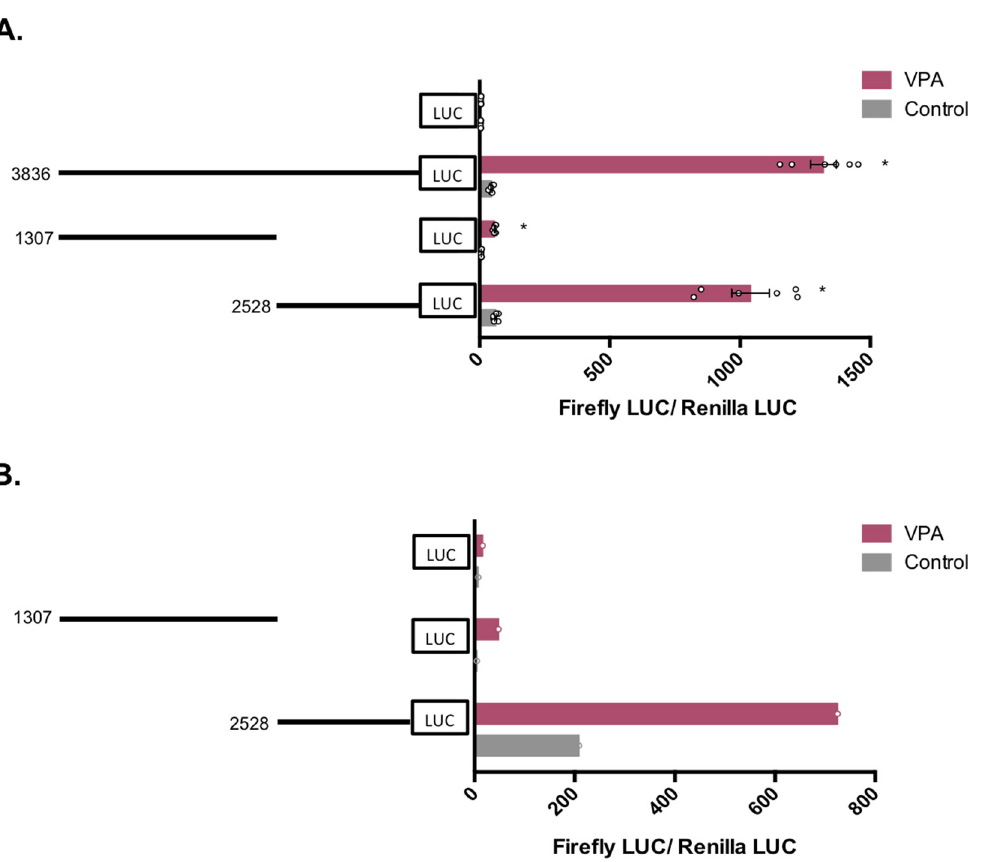
Figure 4. Response of three hVDR (human Vitamin D Receptor) gene promoter regions of 3836 bp, 1307 bp, and 2528 bp to VPA (valproic acid). HepG2 cells ( A ) or human hepatocytes ( B ) were transfected with the pGL4-VDR-3836 ( − 1899 to +1937), pGL4-VDR-1307 ( − 1899 to − 592), pGL4-VDR-2528 ( − 591 to +1937), or pGL4 empty vector and treated with 5 mM VPA, or vehicle. Firefly luciferase activity was normalized with Renilla luciferase activity (relative light units, RLUs). Results are expressed as mean ± SEM from six independent experiments. * p -value < 0.05, t -test ( A ). Single experiment values are shown for Upcyte hepatocytes ( B ).